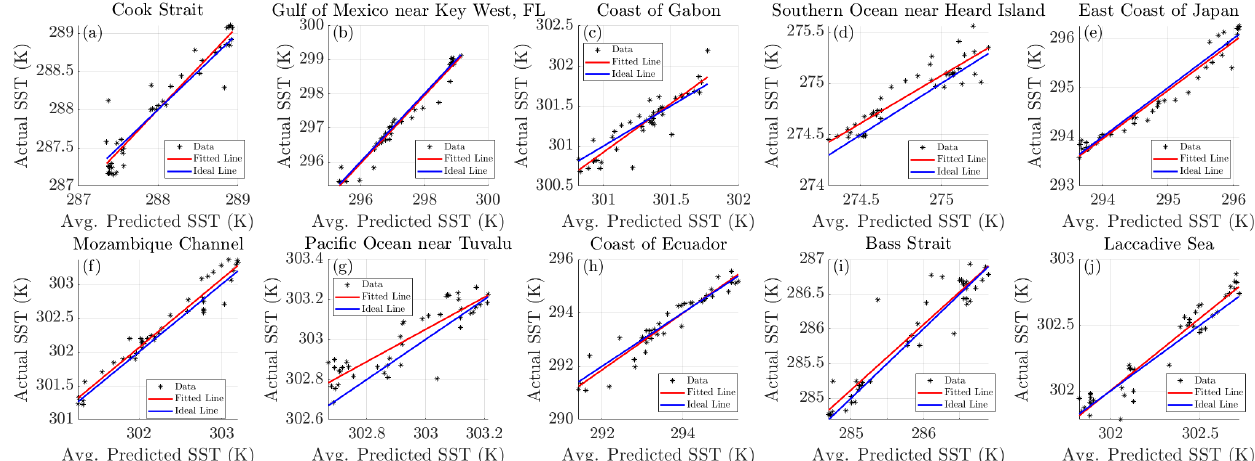
Figure 5. The true SST compared to the average predicted SST, for the model predicting 1d at a time. The red line indicates the resulting linear fit, and the blue line is the ideal place where the forecasted SSTs would match the true